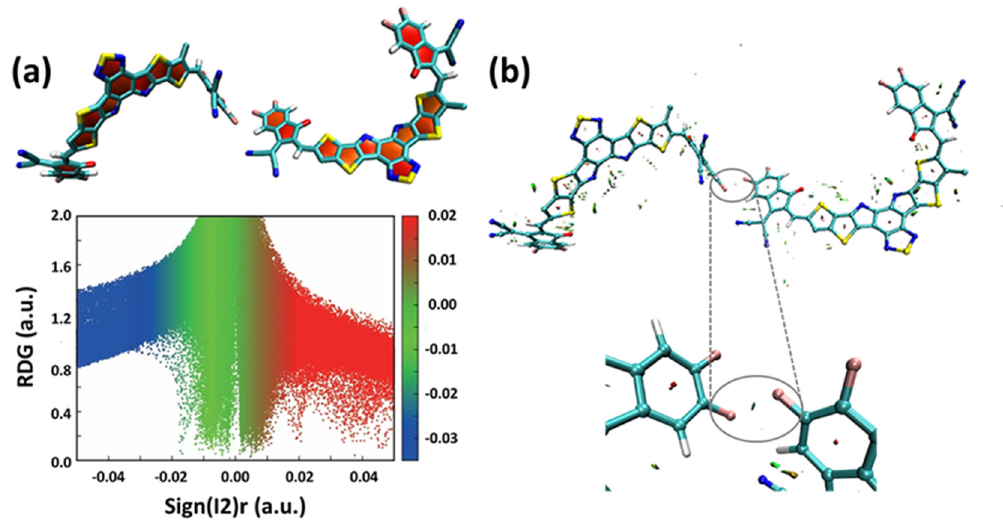
Figure 4. ( a ) Plot of the reduced density gradient versus the electron density multiplied by the sign of the second Hessian eigenvalue for Y6 evaluated by B3LYP/6 − 31G(d). ( b ) The NCI diagram for the Y6 dimer.